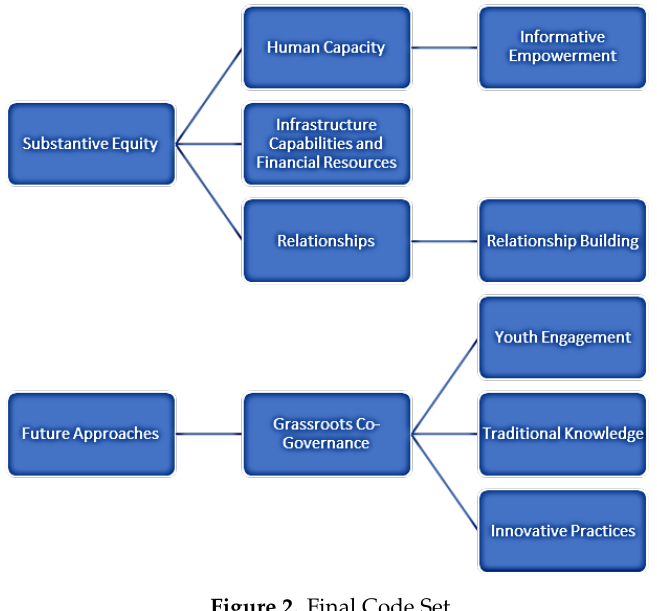
Figure 2. Final Code Set.